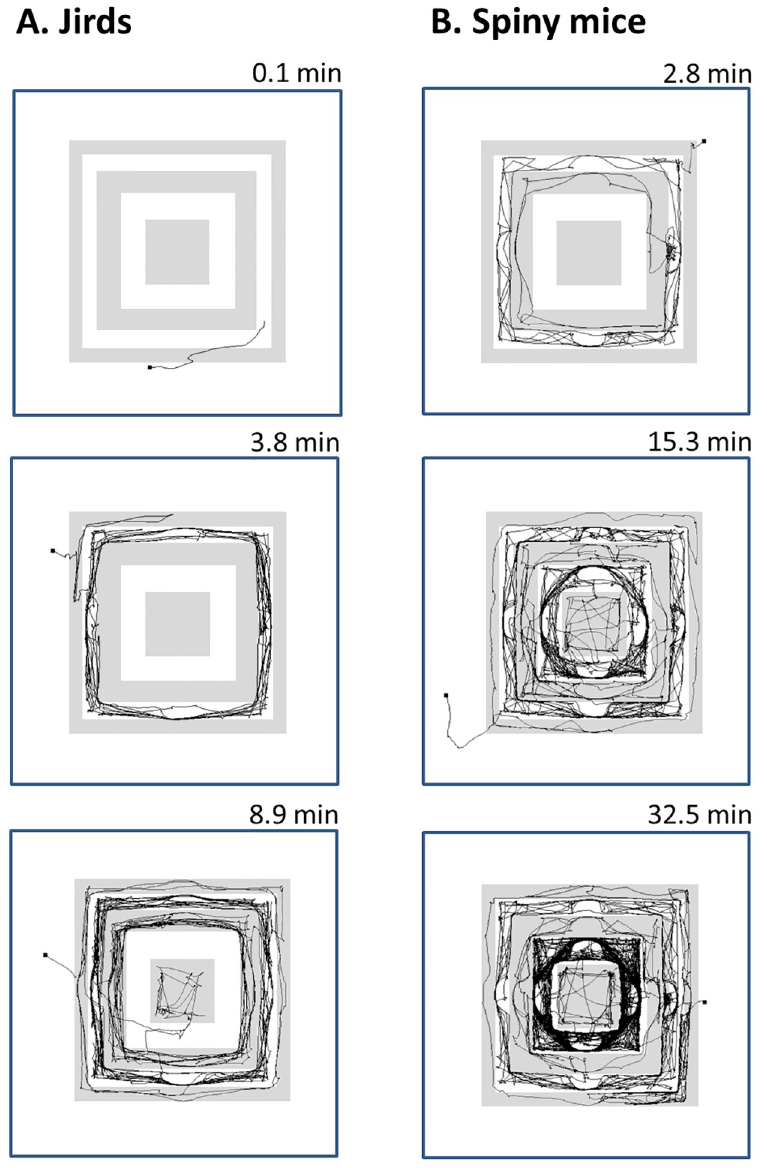
Fig 4. Trajectories of the routes passed by jirds (A) and spiny mice (B) are depicted for the period from the start until the first arrival to the floor. The jird and the spiny mouse that were fastest to reach the floor are depicted at the top row. The jird and spiny mouse that were closest to the mean time of the group for reaching the floor are depicted in the middle row, and the jird and spiny mouse that were latest to reach the floor are depicted at the bottom row (the five spiny mice that never reached the floor were excluded from this figure). As shown, jirds preferred to soon descend down to the lower levels and the floor. The jird at the bottom row was the only one that ascended above the starting level before descending down. In contrast, spiny mice travelled the pyramid levels for longer time (and distance), and all of them climbed above the starting level before descending to lower levels or to the floor. base on the floor. This reflects Fig 3, reconfirming the preference of jirds to travel on the floor or near it and establishing their bases there, in contrast to the spiny mice’s preference to travel on the pyramid and establish their home-bases there. On the pyramid, jirds mainly travelled on the lower levels whereas spiny mice travelled equally on all the levels.